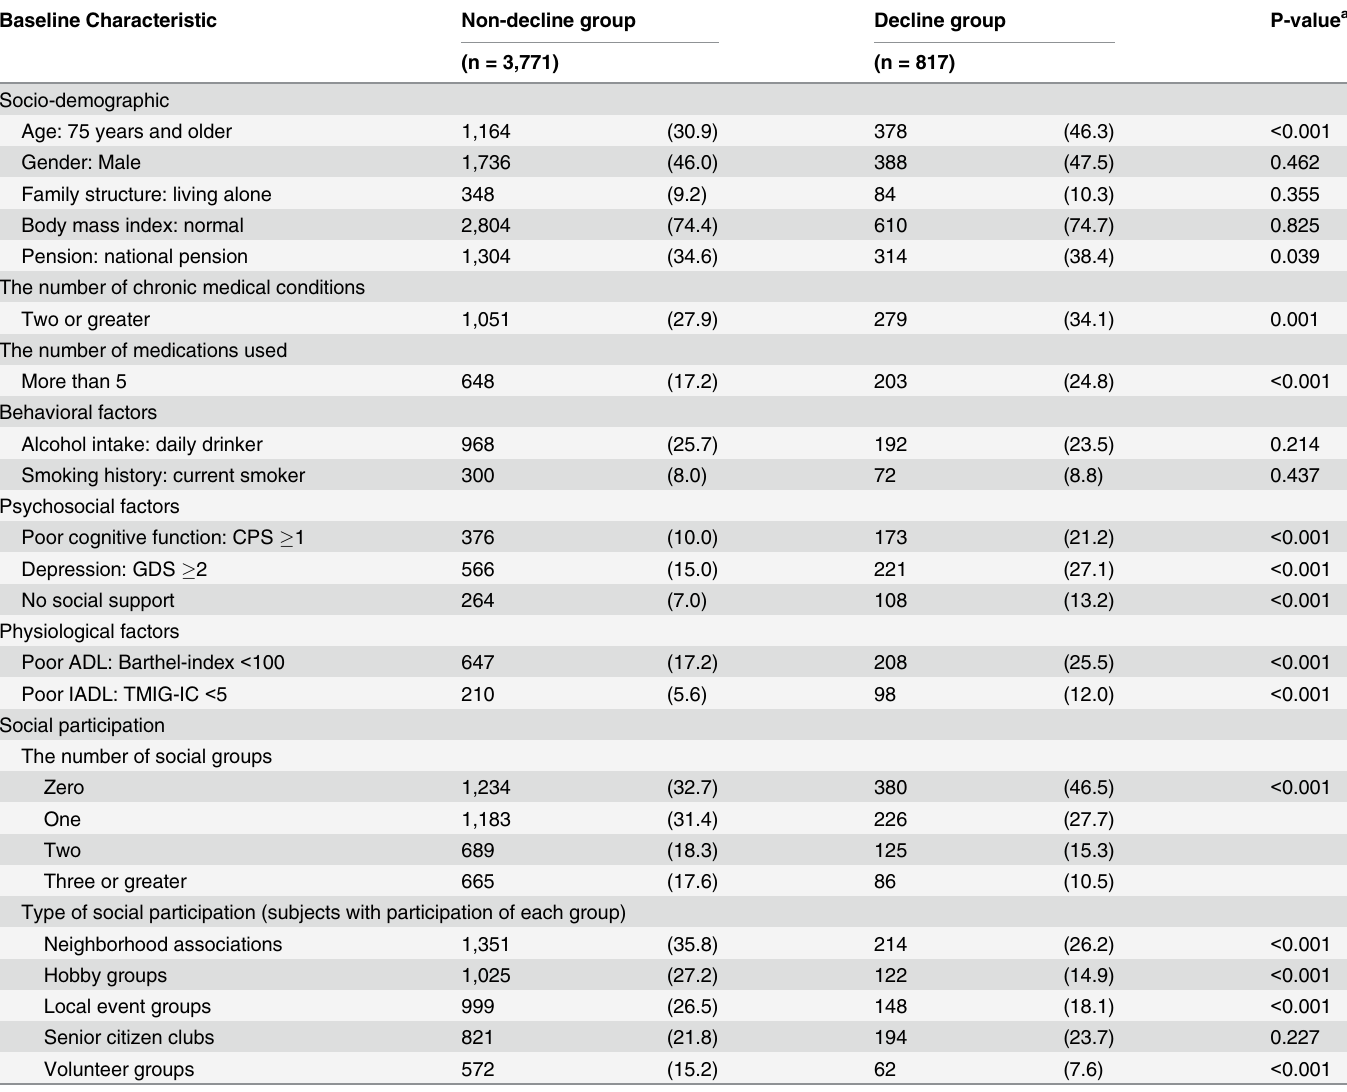
Table 3. Characteristics of study participants at baseline stratified according to the decline in effectance during the 3-year follow-up Baseline